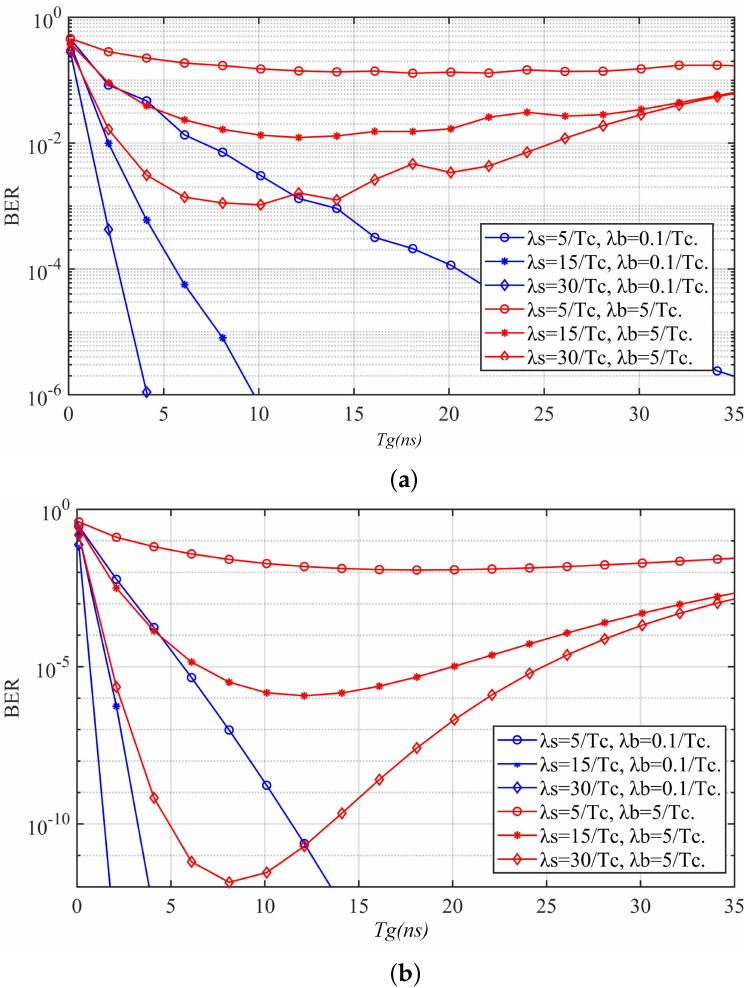
Figure 4. The influence of gated-ON time on the performance of time-gated SPAD. ( a ) N g = 16. ( b ) N g =